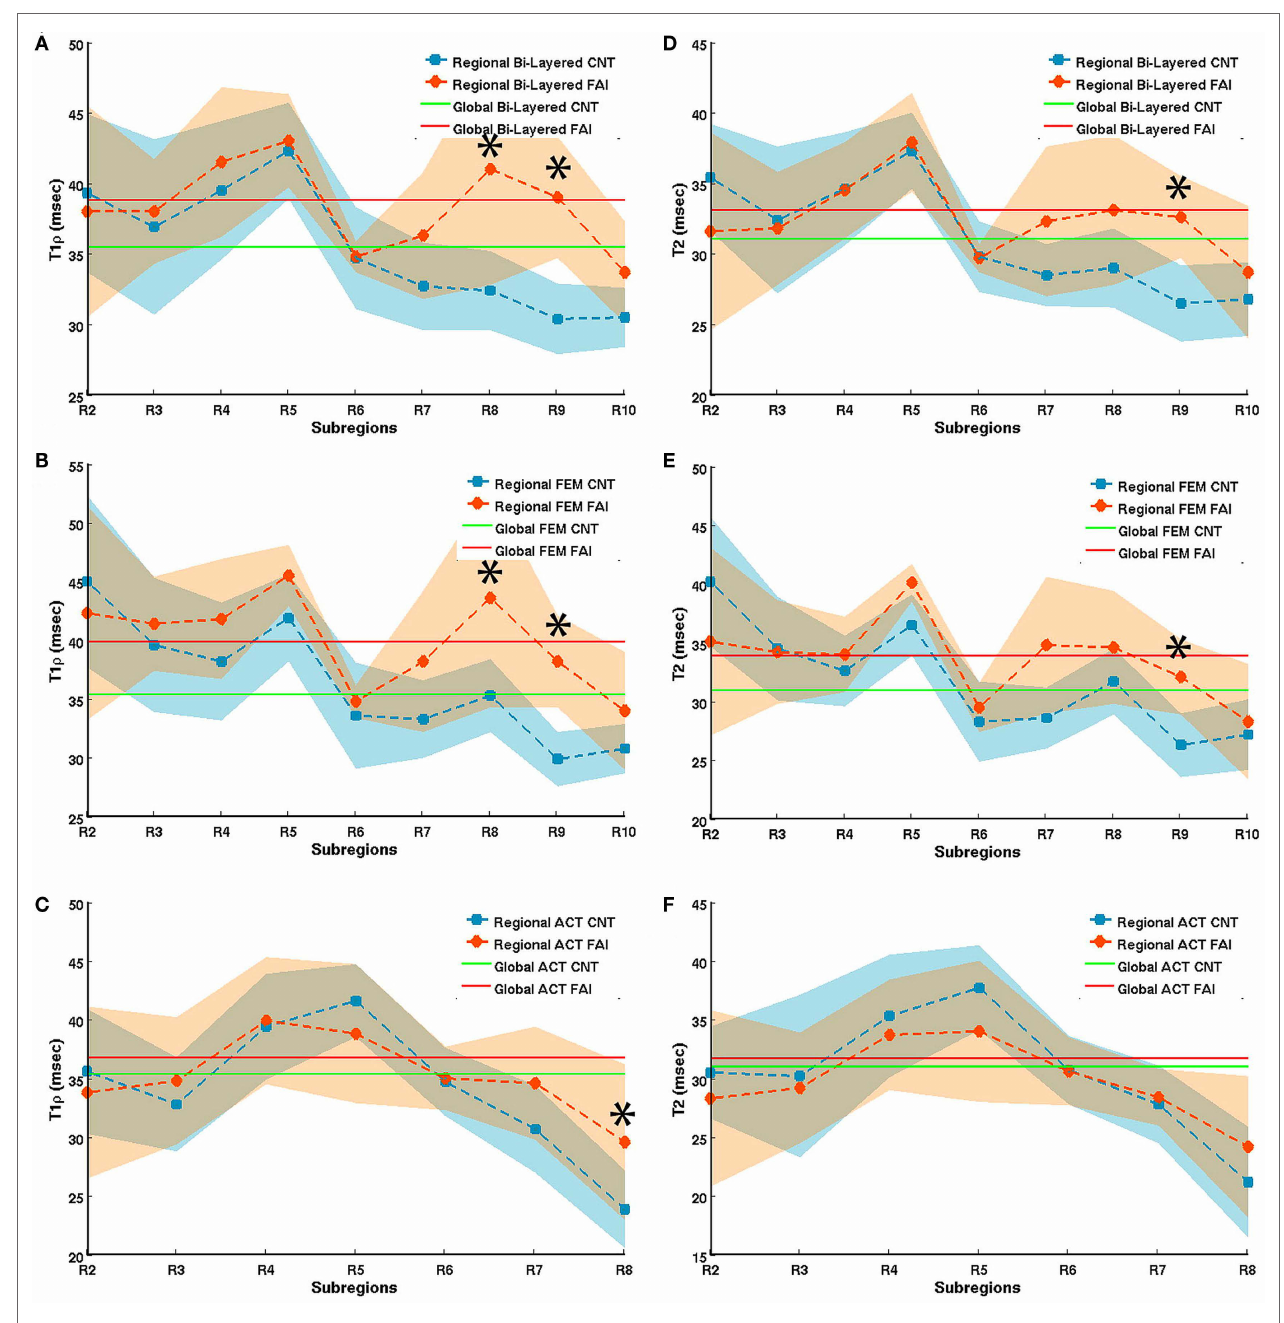
which R2 represents the posterior–inferior region (5–4 o’clock in a clockwise system, right hip), R5 the posterior–superior (2–3 o’clock), and R8 the anterior–superior (1–2 o’clock) region. Error bars represent SD. *represents a significant difference between relaxation times of controls and FAI subjects. Figure reprinted with permission